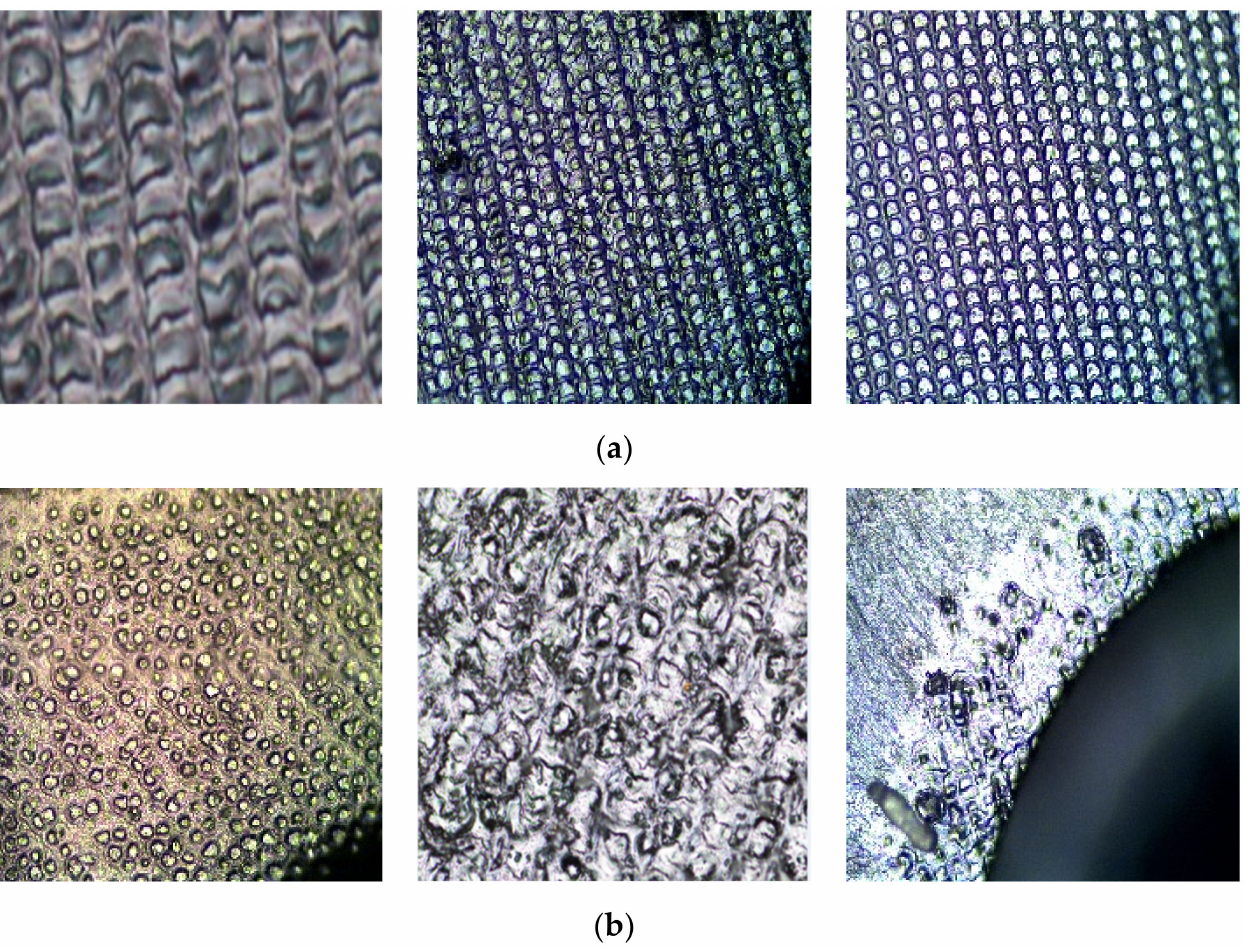
Figure 3. Types of laser engraving defects. ( a ) Defect-free surface; ( b ) defect